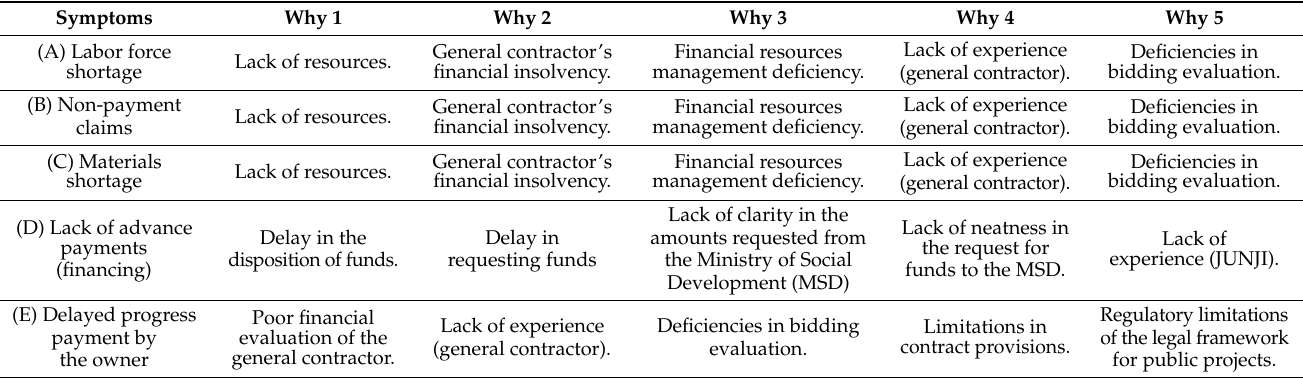
Table 4. Root-cause analysis results of case study